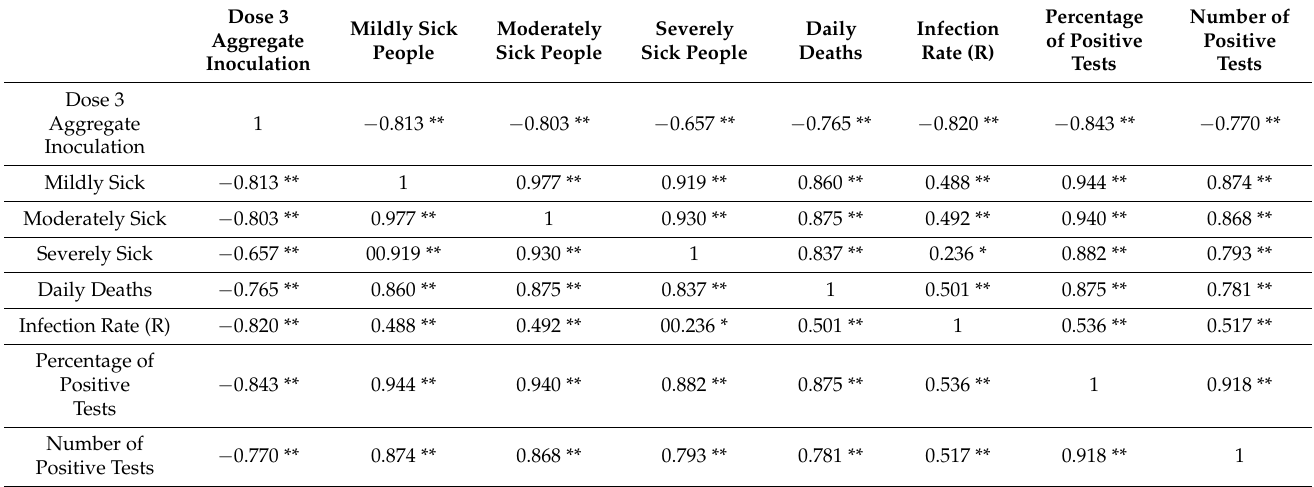
Table 7. Correlation between dose 3 and the sickness factors from 1 August 2021 to 19 October 2021.